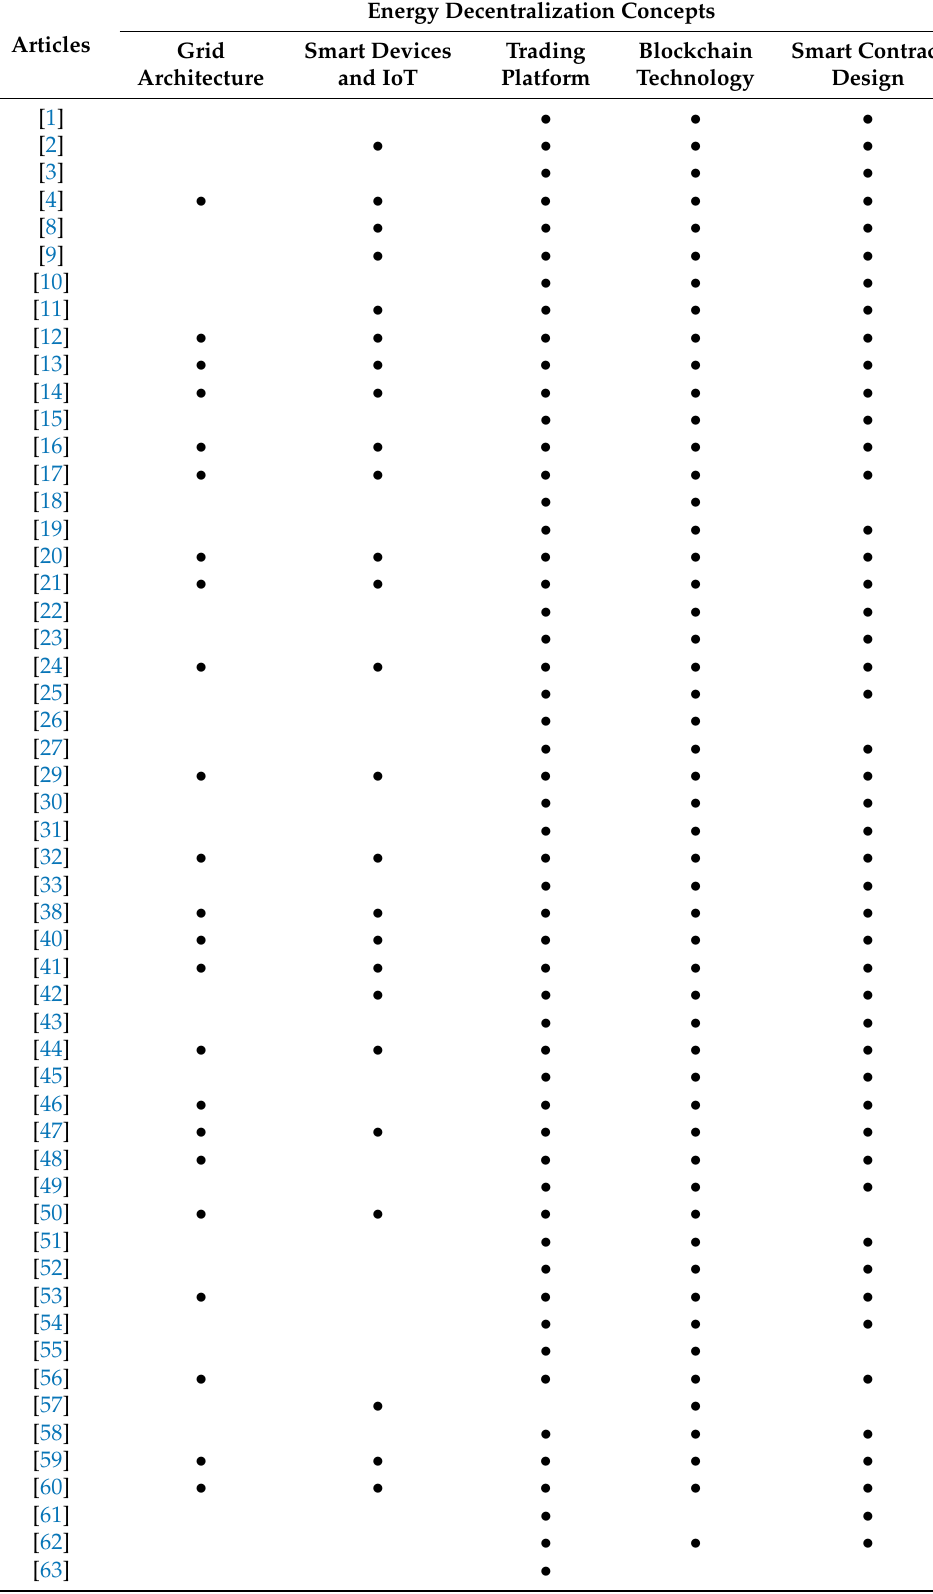
Table 6. Classification of the reviewed articles according to energy decentralization